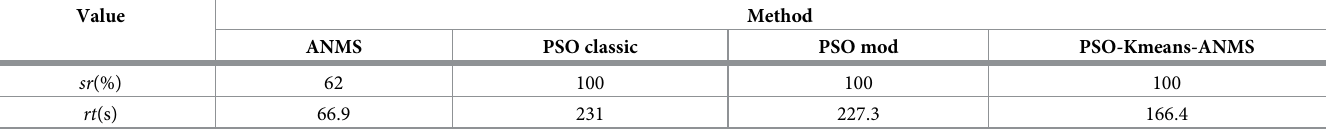
Table 11. Case 2 (50 × 40). Results of the success rate ( sr ) and the average execution time ( rt ) for each optimization algorithm. Value